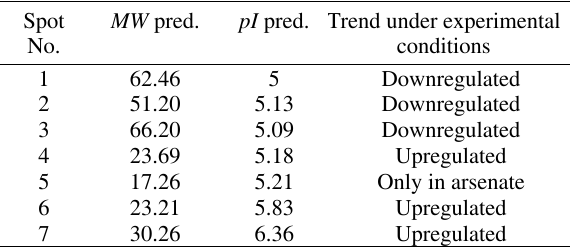
Table 2 . Description of the differentially expressed proteins in the cells of P. fluorescens CECT 378